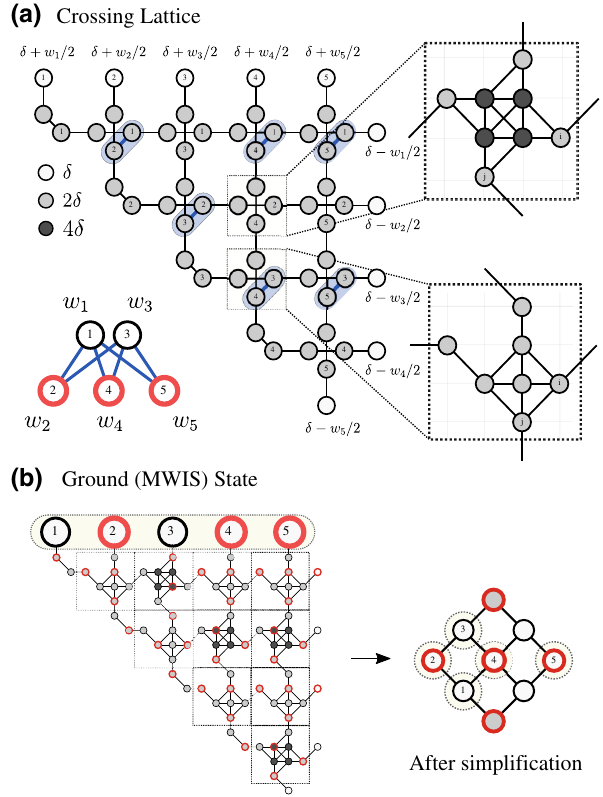
FIG. 6. Example encoding procedure for the MWIS problem on the K 2,3 (non-unit-disk) graph into UDG-MWIS. (a) Cross- ing lattice. Each vertex v is represented by a line using the copy gadget, with odd-numbered vertices labeled. Each line is bent to form a triangular lattice, giving a crossing point between any two variables. If the two variables share an edge in the original graph, we draw an edge between their representative vertices on the lat- tice. A UDG is then obtained by replacing each crossing with a crossing or crossing-with-edge gadget. (b) UDG representation and the corresponding ground-state solution. Each crossing in (a) is replaced with a unit cell containing at most eight vertices, thus resulting in a final mapping with 92 vertices. The MWIS of the original graph ( { 2, 4, 5 } ) can be read out from the boundary ver- tices of the ground state of the mapped graph. This mapping can further be simplified (see Fig. 10) to a mapping of only nine ver- tices, where the vertices corresponding to the original degrees of freedom still encode the desired MWIS